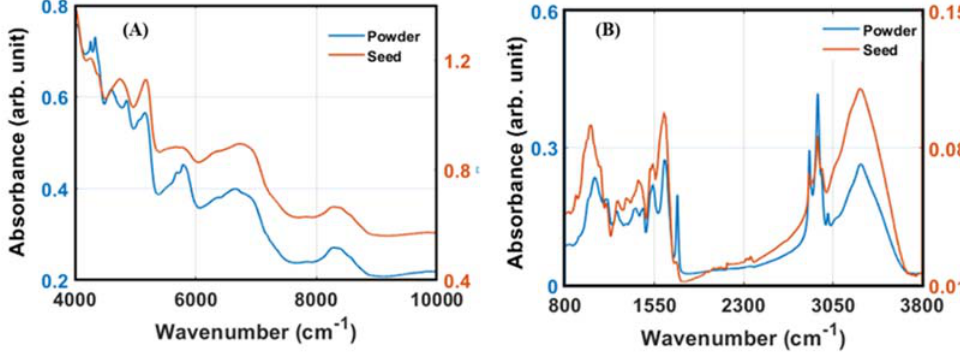
Figure 3. The typical pattern of raw spectra of soybean acquired using FT-NIR ( A ) and FT-IR ( B ).